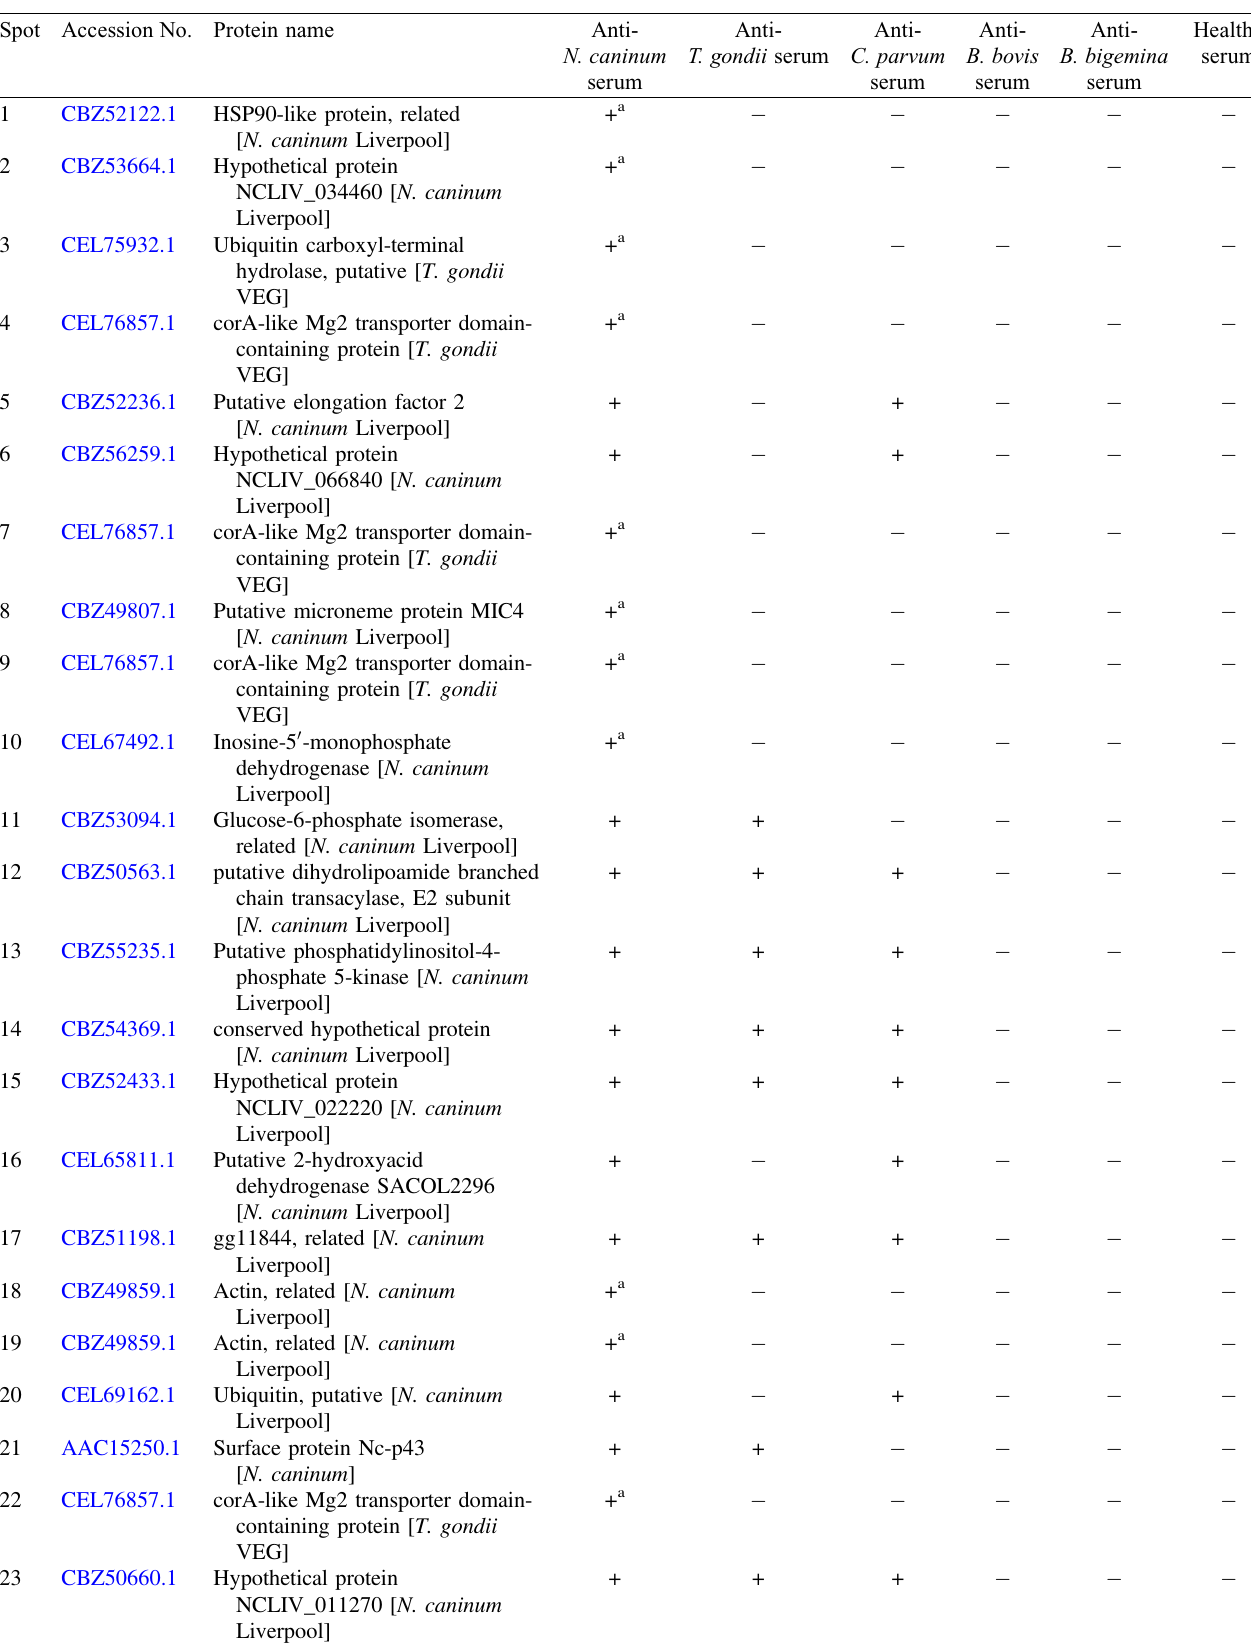
Table 3. List of proteins identi fi ed as speci fi c and/or cross-reactive antigens of Neospora caninum and other apicomplexan protozoa in the bovine